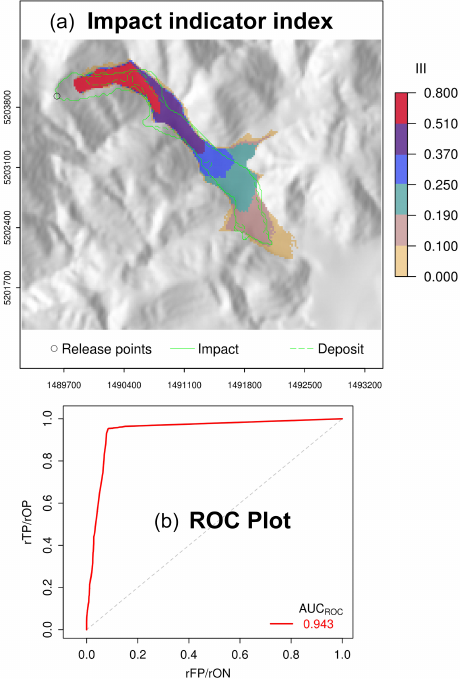
Figure 8. Impact indicator score for the Acheron rock avalanche. (a) Classified III map. (b) ROC plot, building on normalized ON area (see Sect. 2.5).